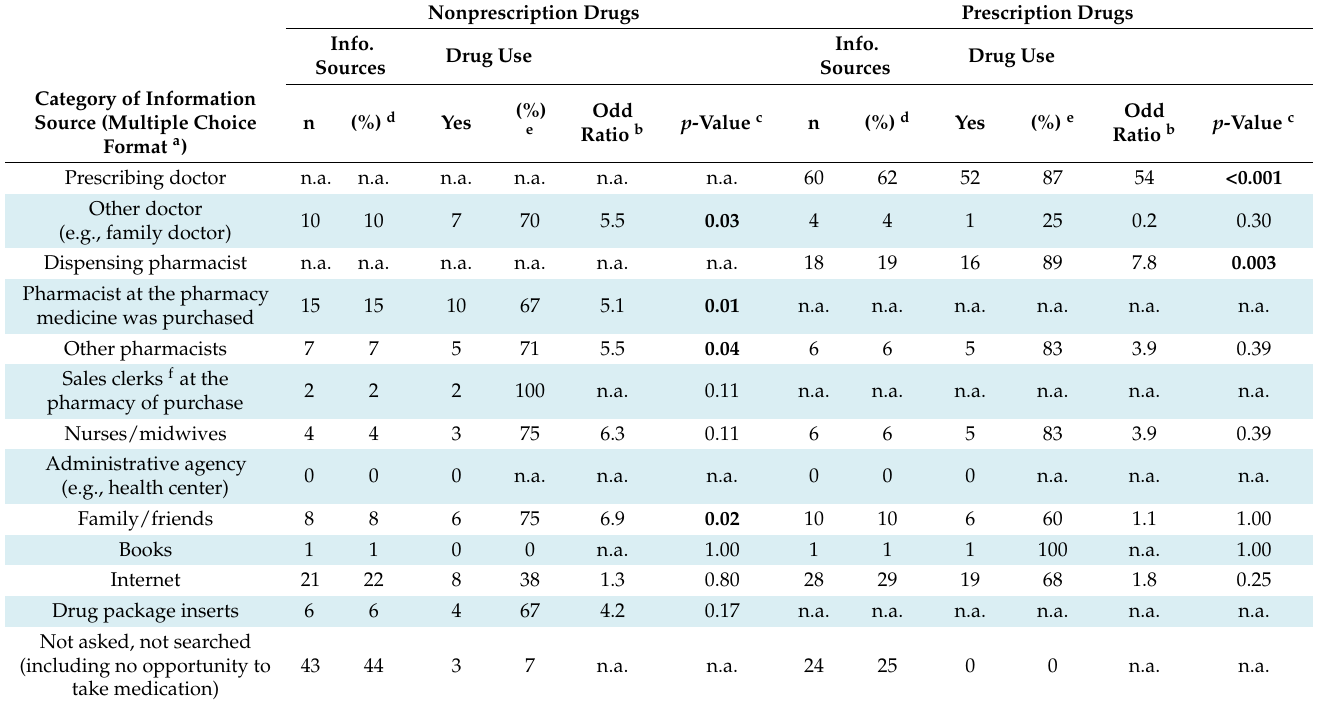
Table 4. Drug information sources for the breastfeeding group (n = 97), with multiple choice